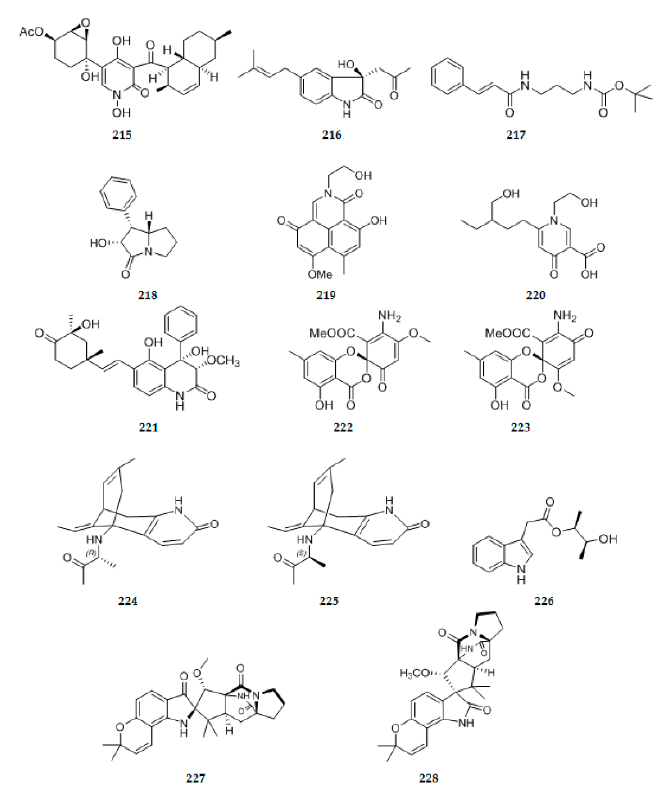
Figure 7. Chemical structures of alkaloids and their derivatives.